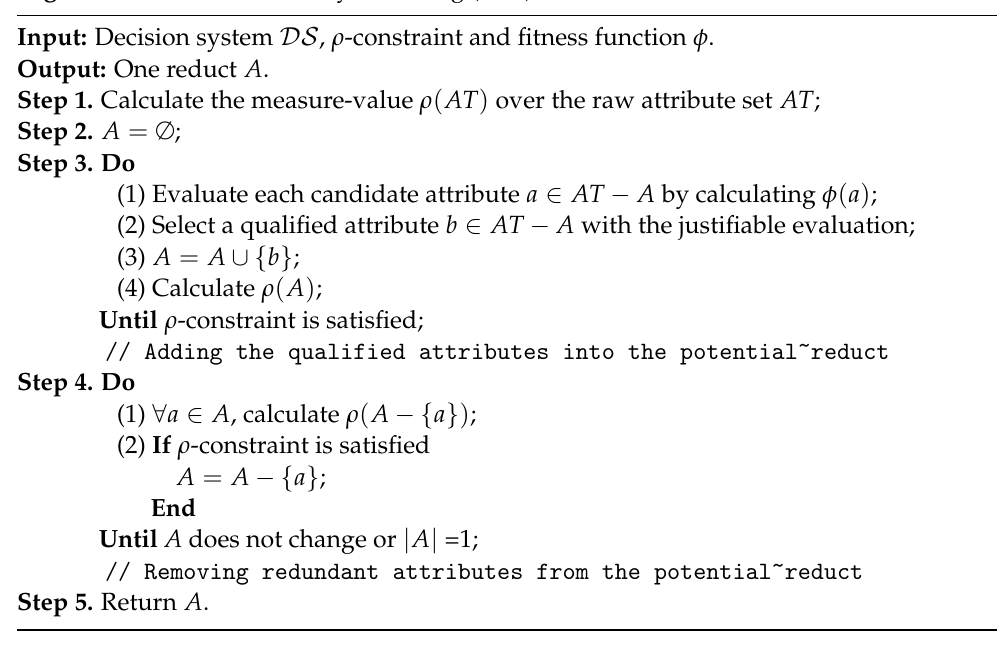
Algorithm 1. Forward Greedy Searching